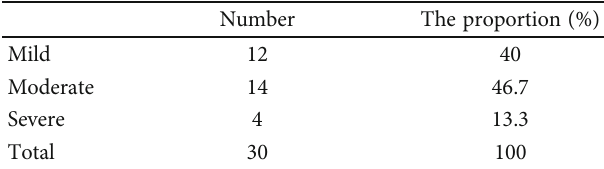
Table 1: Prostate in fl ammation